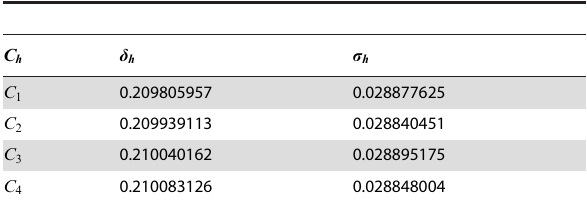
Table 3. Scenario 2 average within distance and relative standard deviation for communities simulated with b ~ 50 and a ~ 25 .